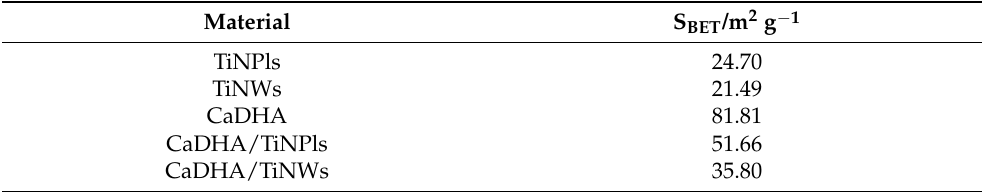
Table 3. Brunauer–Emmett–Teller (BET) surface area of the TiO 2 nanoplates (TiNPls), nanowires (TiNWs), precipitate formed after 60 min reaction time in the control system (calcium deficient hydroxyapatite, CaDHA) and in the presence of 100 mg L − 1 TiO 2 nanoplates (CaDHA/TiNPls) and nanowires (CaDHA/TiNWs). c (CaCl 2 ) = c (Na 2 HPO 4 ) = 4 · 10 − 3 mol dm − 3 , pH init = 7.4, ϑ = (25 ± 0.1) ◦ C.